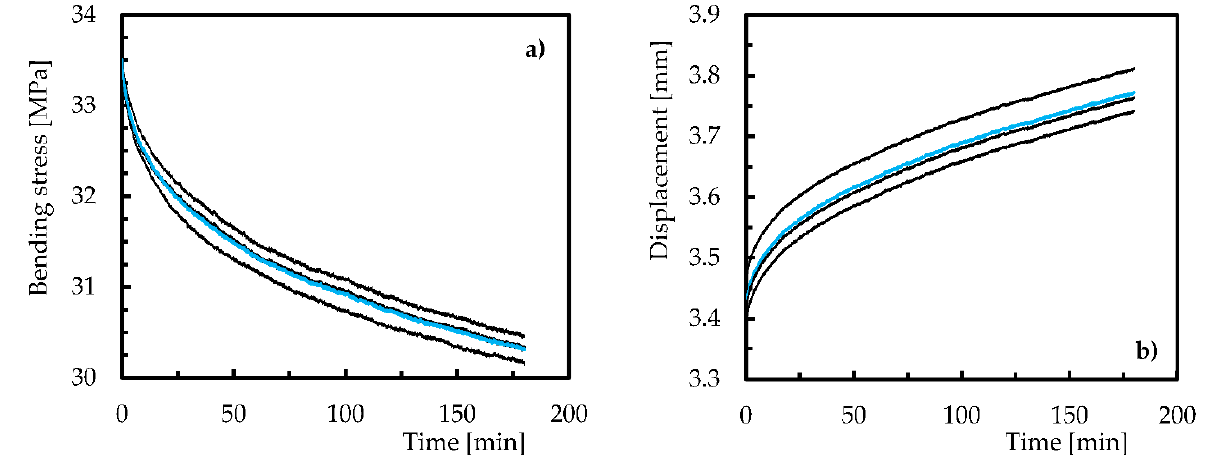
Figure 5. Repeatability of the curves for PETG for 50% of the maximum bending stress: ( a ) stress relaxation; ( b ) creep.